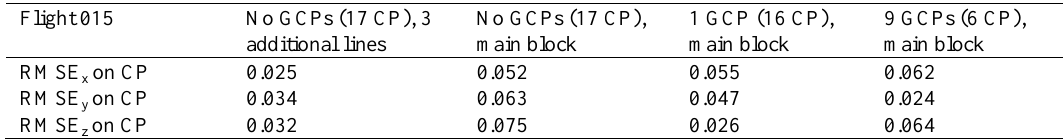
Table 2: RMSEs (in m) for flight 015, 1 cm